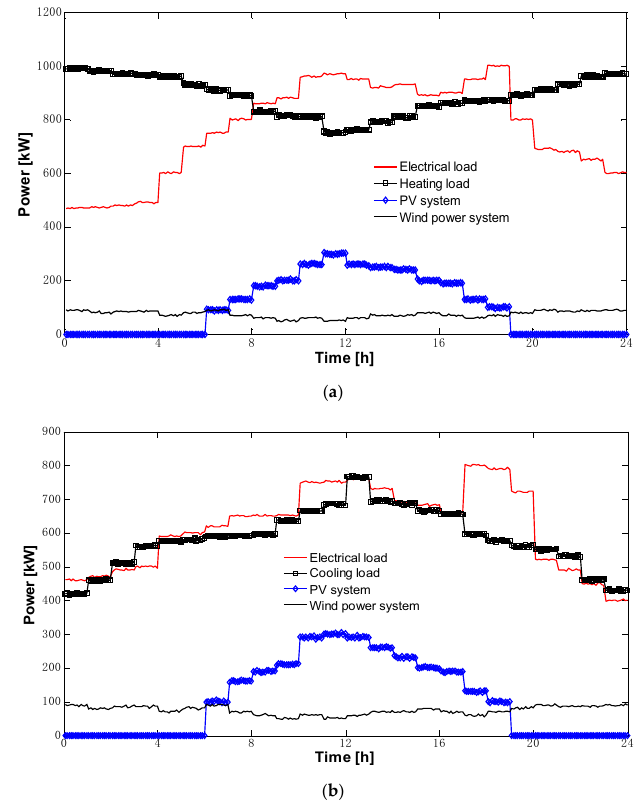
Figure 7. Intraday ultra-short-term predictive data of the wind and PV power generation system, and the cooling-heating-electricity load in: winter ( a ); and summer ( b ).